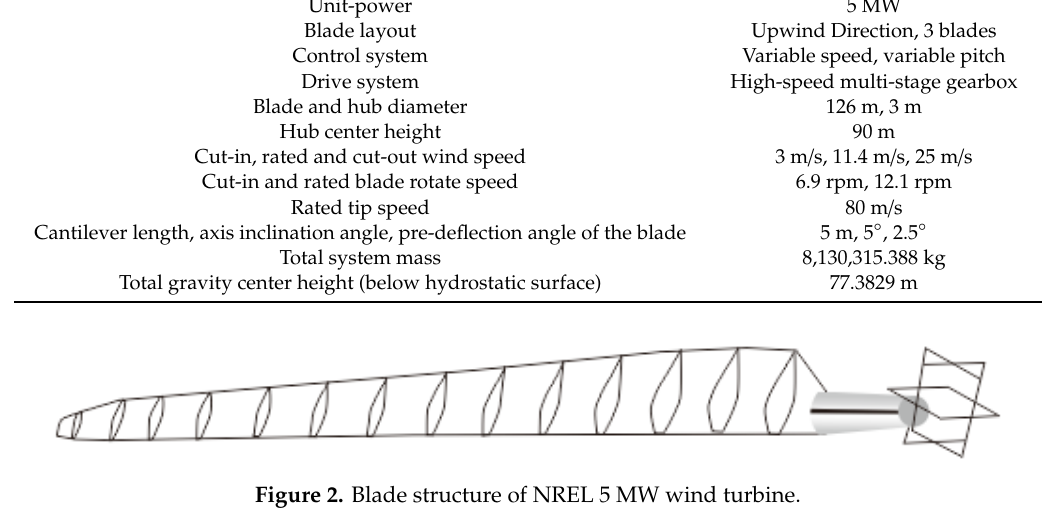
Figure 1. FAST Simulink S-function.